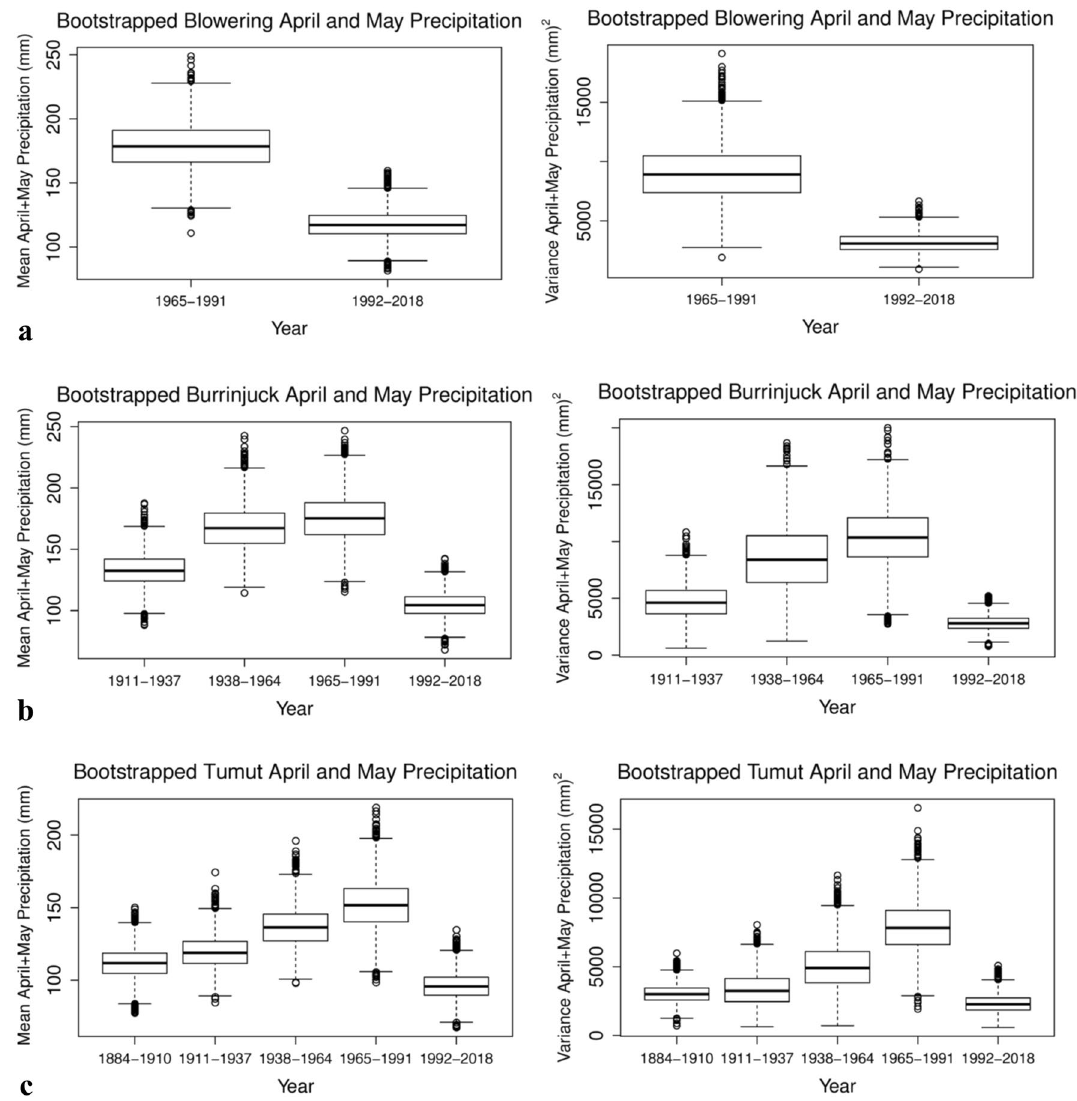
Figure 4. Boxwhisker plots representing mean and variance of April–May Murrumbidgee catchment precipitation. Bootstrapped 27-year intervals of mean (left panel) and variance (right panel) of April–May precipitation for, (a) Blowering Dam, (b) Burrinjuck Dam, (c)